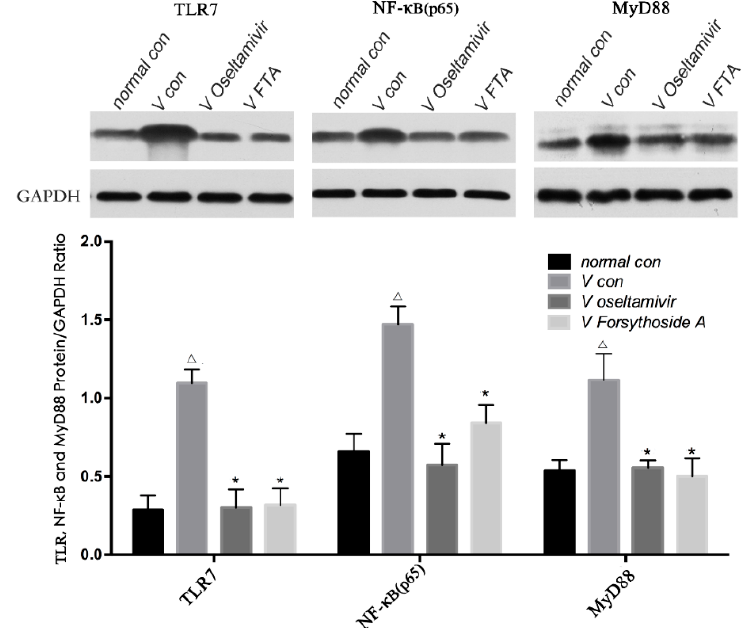
Figure 6. Relative protein expression of TLR7, NF- κ B p65 and MyD88. Compared with the normal con , TLR7, MyD88 and NF- κ B p65 protein expression was gradually enhanced in V con . Compared with the V con , the relative protein expression of TLR7, MyD88 and NF- κ B p65 was down-regulated in V Oseltamivir and V FTA . Δ p < 0.01 compared with normal con . * p < 0.01 compared with V con .